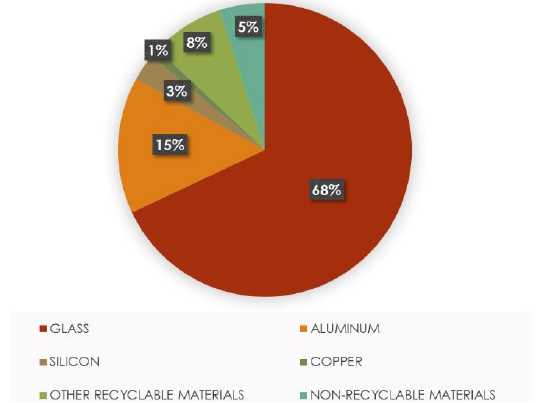
Figure 6. Recyclable materials in PV panels.